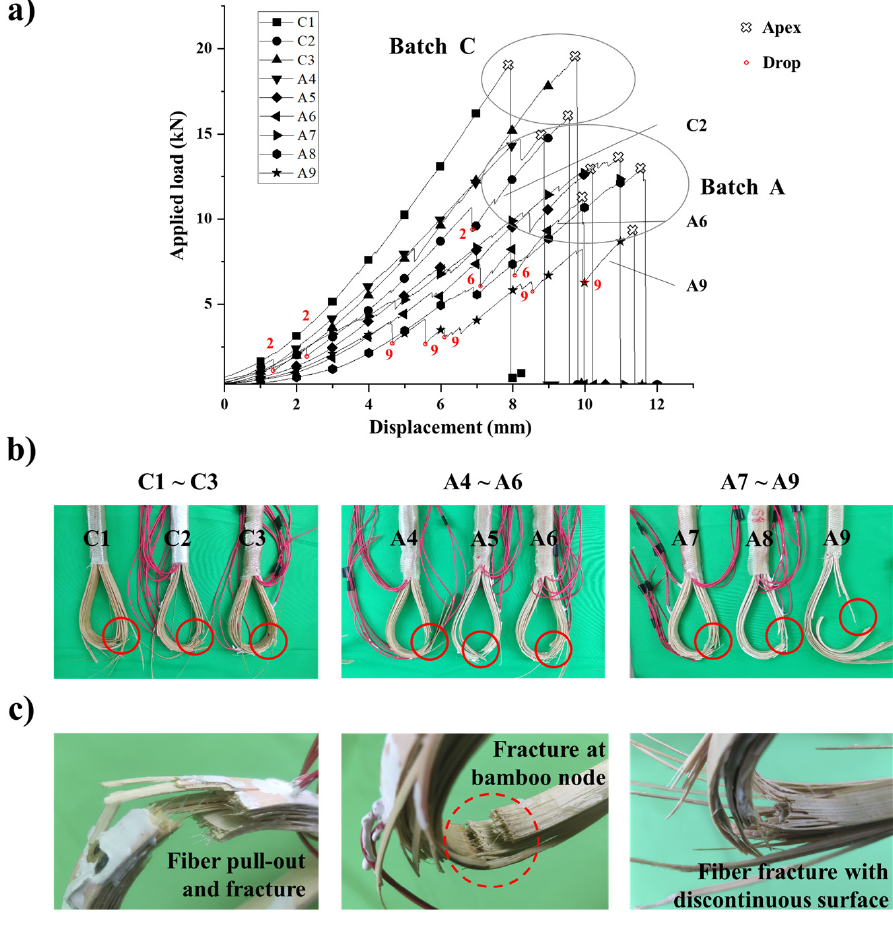
Figure 10. ( a ) Loading curves of nine BFRP tendon specimens with particular marks; ( b ) failure modes of nine BFRP tendon specimens; ( c ) details of the failure surfaces.